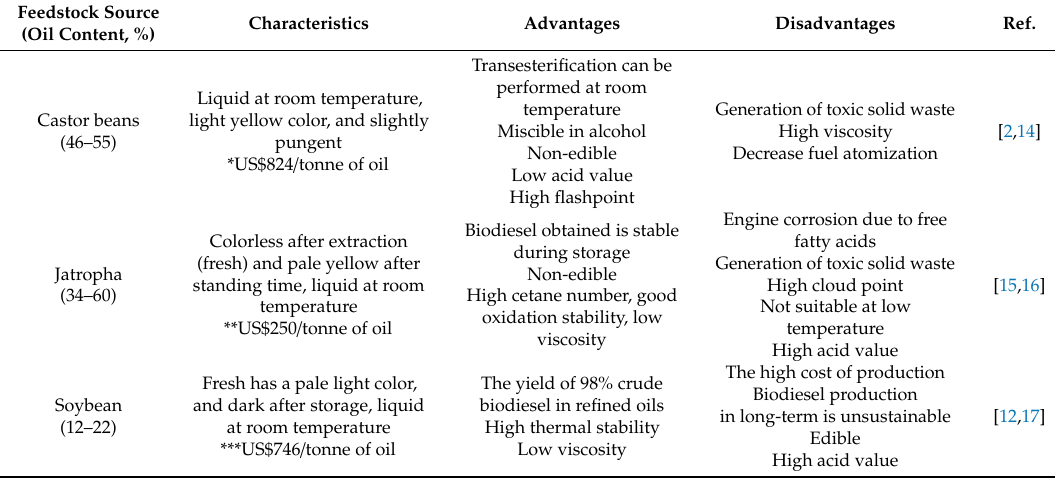
Table 1. Examples of oil-feedstock used in biodiesel production. Feedstock Source (Oil Content,